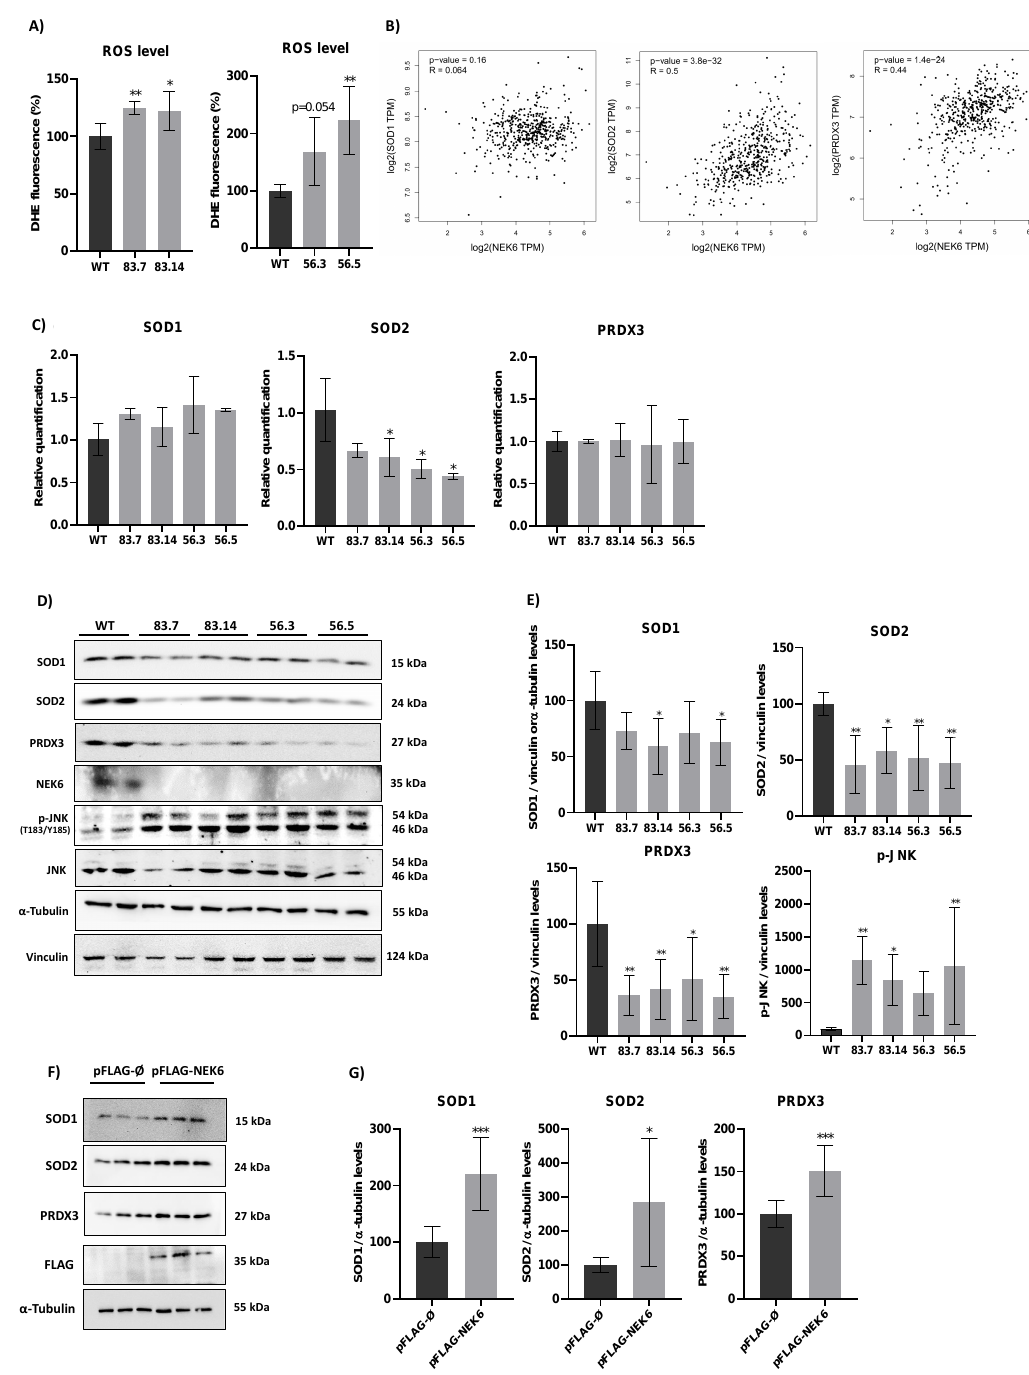
Figure 3. NEK6-KO increases ROS levels and its expression modulates antioxidant defenses in DU-145 cells. ( A ) DU-145 WT and NEK6-KO’s ROS levels were measured by DHE staining in flow cytometry. NEK6-KO showed an increase in ROS levels when compared with WT cells. ( B ) Correlation of the gene expression in prostate adenocarcinoma (PRAD) using the GEPIA platform. Spearman’s coefficient was used to measure the intensity of the correlation between genes. ( C ) mRNA levels of SOD1, SOD2, and PRDX3 were analyzed through RT-qPCR. A significant reduction in mRNA of SOD2 was observed. ( D ) The expression of antioxidant proteins (SOD1, SOD2, and PRDX3) was evaluated by Western blotting. Target deletion of the NEK6 gene reduces the expression of SOD1, SOD2, and PRDX3. Additionally, high levels of JNK phosphorylation were observed in NEK6-KO cells. ( E ) Quantification of antioxidant protein expression in WT and NEK6-KO cells. ( F ) NEK6 overexpression in DU-145 WT cells upregulated the SOD1, SOD2, and PRDX3 protein expression. ( G ) Quantification of antioxidant protein expression in FLAG-NEK6 expressing cells. * p < 0.05, ** p < 0.01 and *** p <